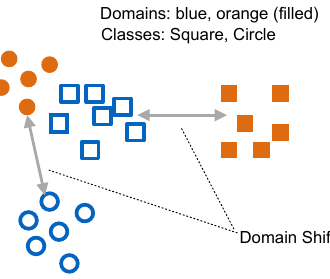
Figure 2. Two domains (color) in a two-dimensional instance space with a classification task (geometric shape)